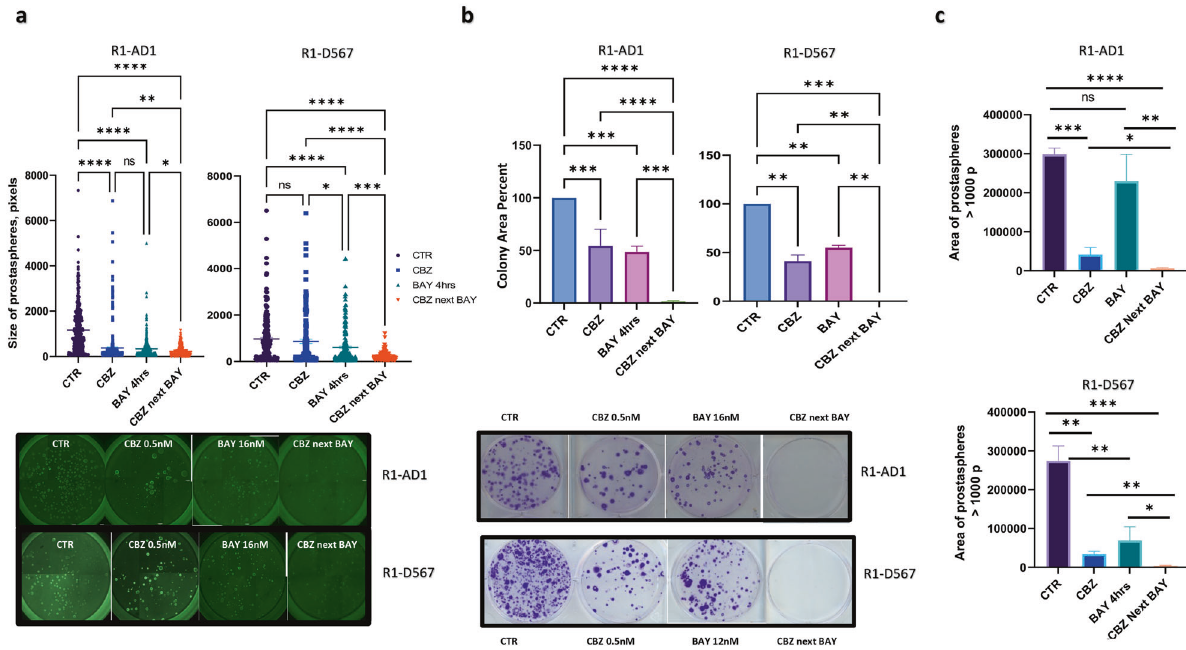
Fig. 5 Mps1i BAY potentiates ef fi cacy of CBZ treatment in 3D prostasphere setting independent of AR status. a R1-AD1 (AR-WT) or R1- D567 (AR-DLBD) prostaspheres were treated as indicated (CBZ 0.5 nM, BAY: R1-AD1 16 nM, R1-D567 12 nM) at day 8 in triplicates. At day 21, prostaspheres were stained with cell viability marker Calcein-AM, and analyzed with ImageJ and Graph PAD Prism (top; average prostaspheres size mean; bar is mean with standard error); representative images (bottom). * p < 0.1; ** p < 0.01: *** p < 0.001; **** p < 0.0001. b Prostaspheres were treated at day 8 as indicated; at day 21, equal volume of trypsinized cells was re-plated in six-well plates in triplicates and documented four weeks later; area of the colonies was calculated with ImageJ (top); columns: mean; error bars: standard deviation. Representative images (bottom). c total area of prostaspheres (R1-AD1: top, R1-D567: bottom) larger than 1000 pixels (by ImageJ analysis) calculated by Graph PAD Prism, mean with standard error. * p < 0.1; ** p < 0.01; *** p < 0.001; **** p <